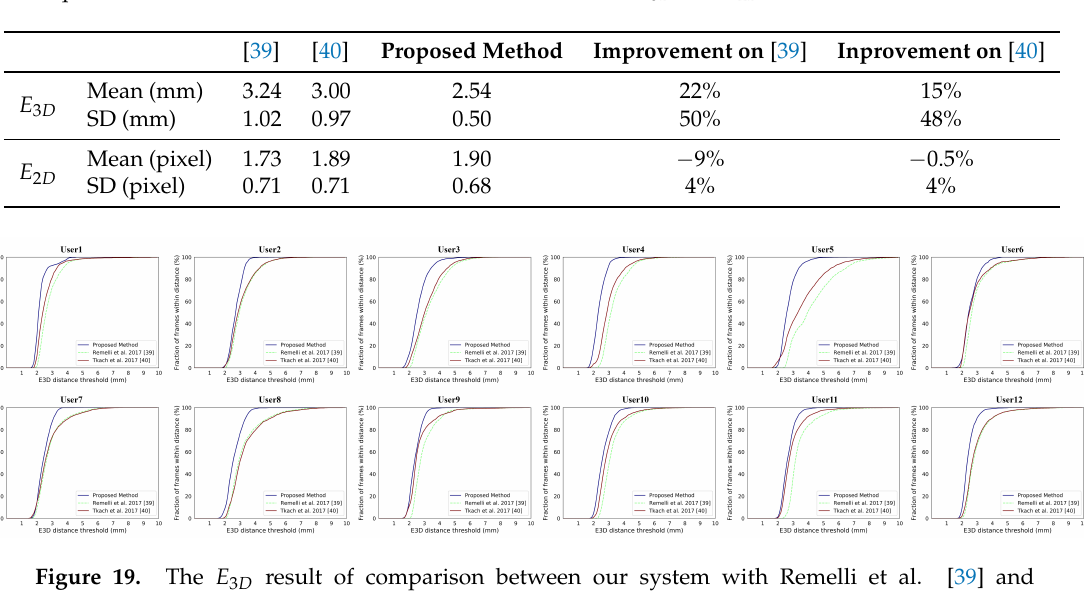
Figure 19. The E 3 D result of comparison between our system with Remelli et al. [39] and Tkach et al. [40] on the 12 subjects in Handy/GuessWho sequence.